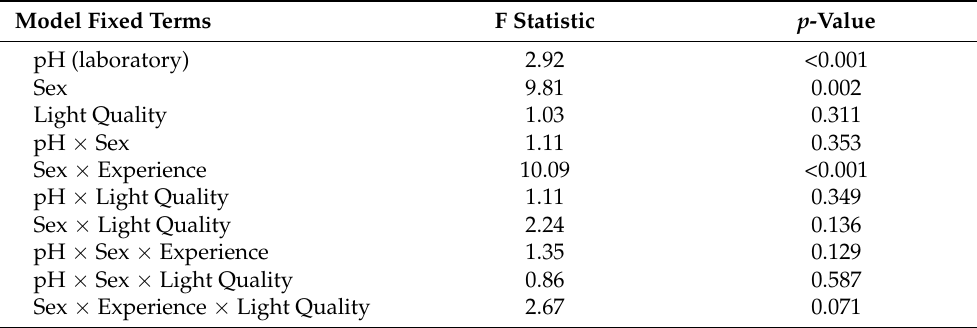
Table 2. Experimental results for the model represented by Equation (9), showing significant effects due to sex and its interaction with experience